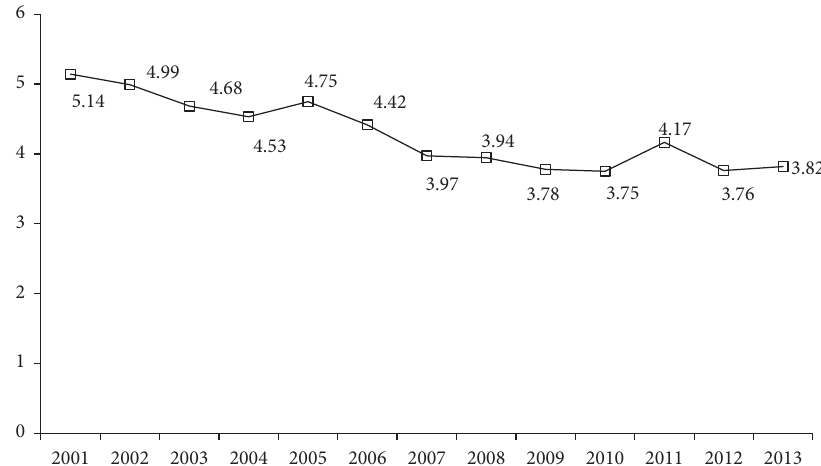
Figure 8: Evolution of average f